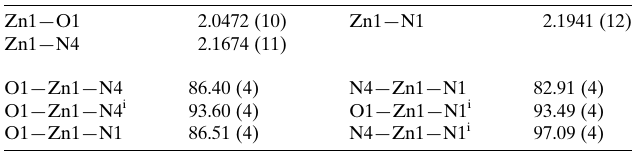
Table 1 Selected geometric parameters (A˚ , (cid:3) ).